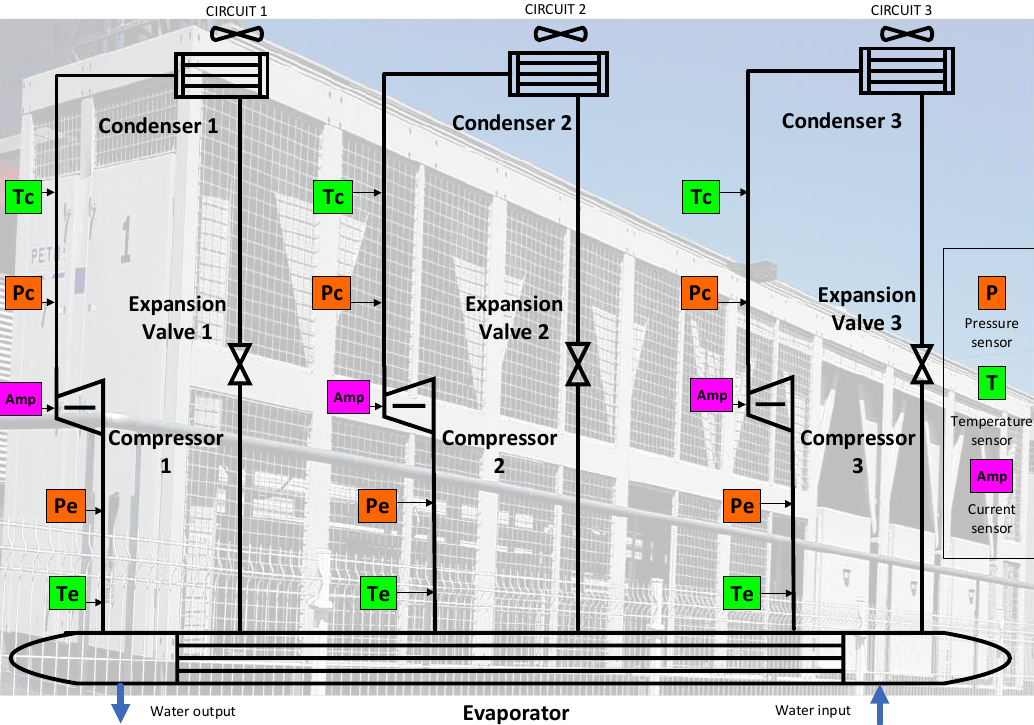
Figure 2. The air-cooled chiller with 3 screw compressors (real photo in the